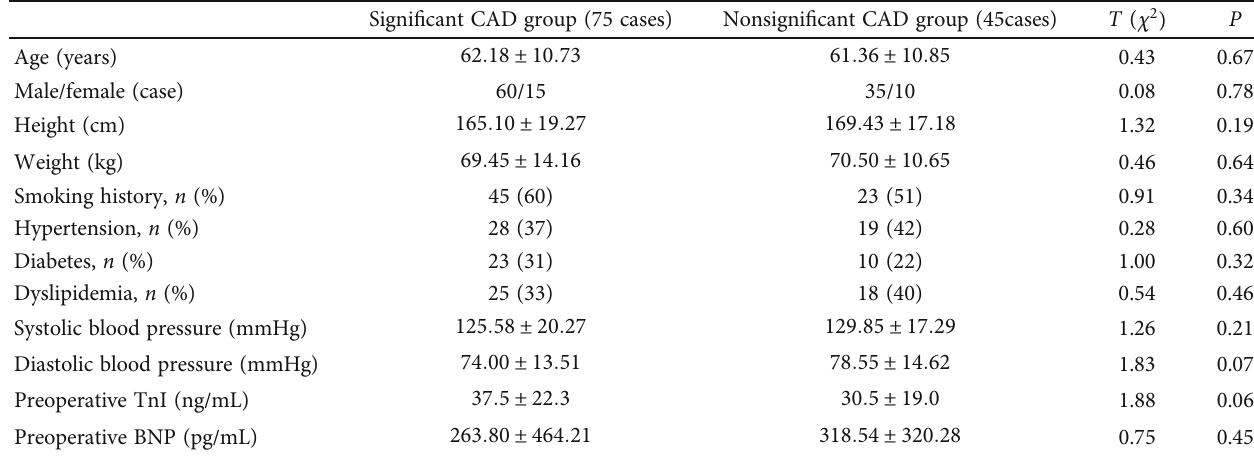
Table 1: Comparison of general